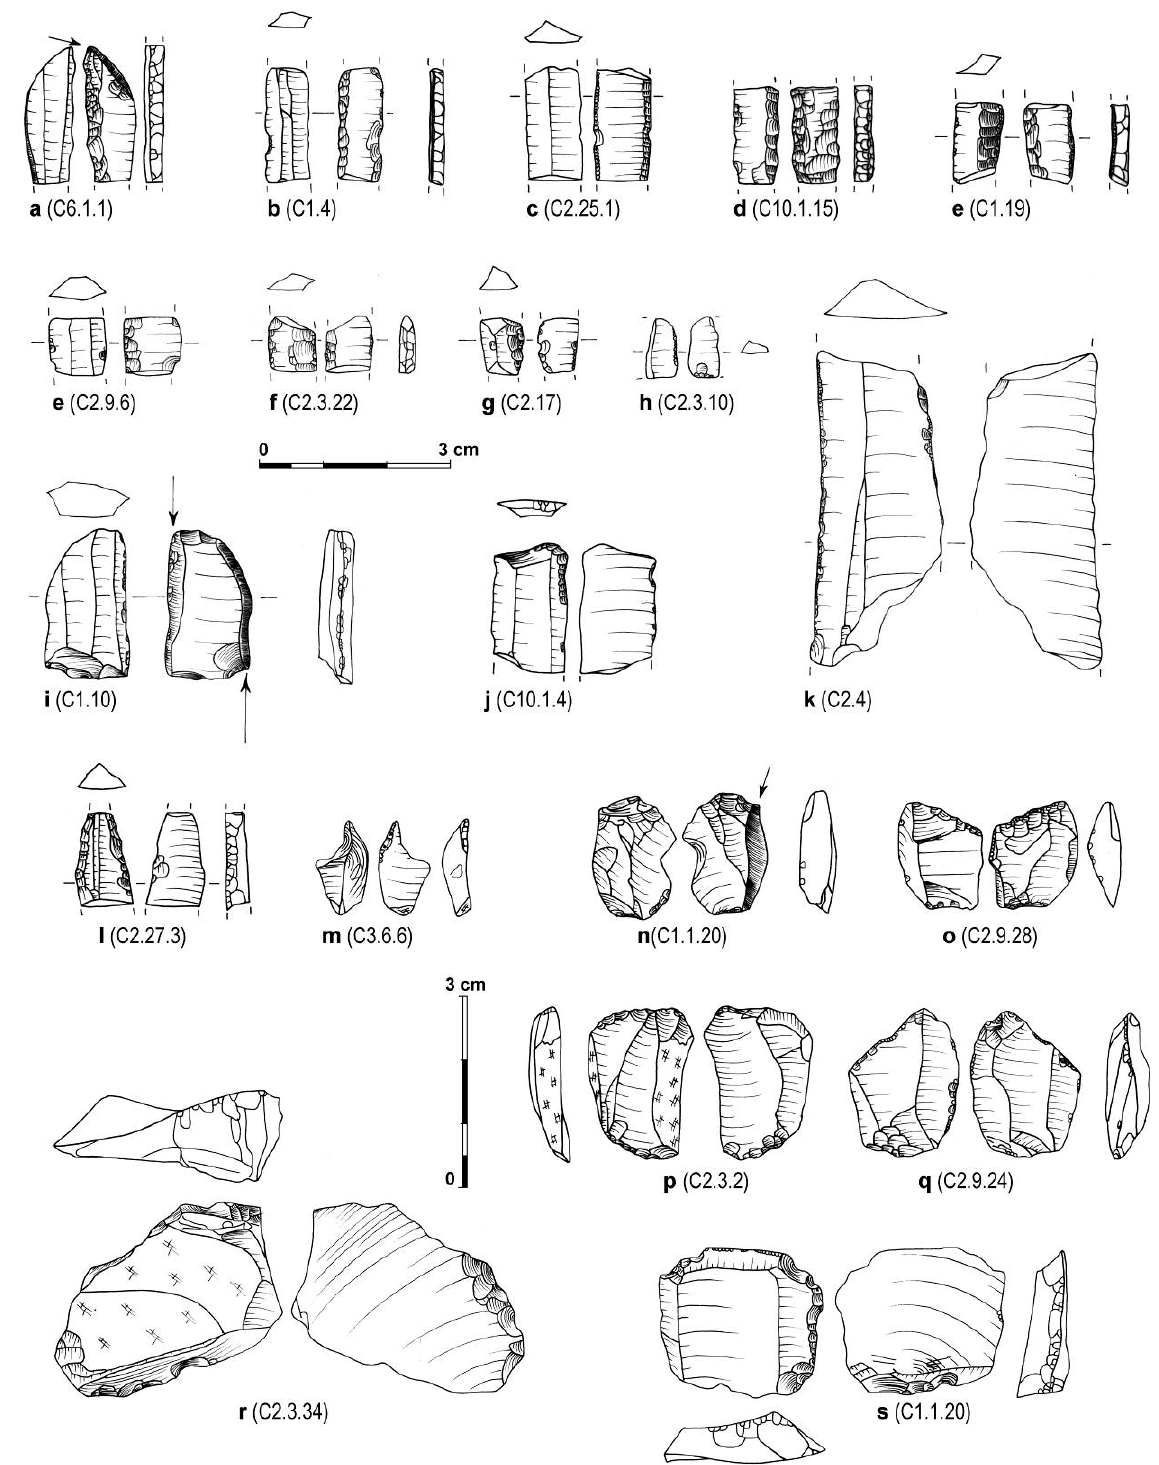
Figure 6. Lithic artefacts from KS C: a-g: backed bladelets; h: retouched bladelet; i: truncation burin; j: truncated blade; k: retouched blade; l: drill; m: microborer; n-q: piéces esquillées ; r-s: scraping tools; all obsidian (drawings by C.